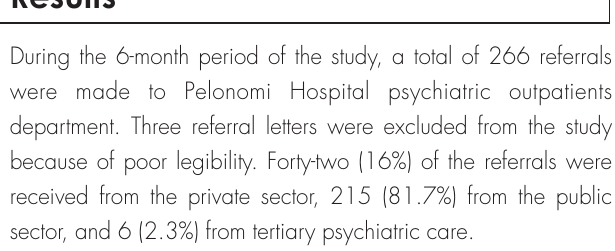
Table II. Criteria screened for regarding identification and con- tact details of referring practitioners and